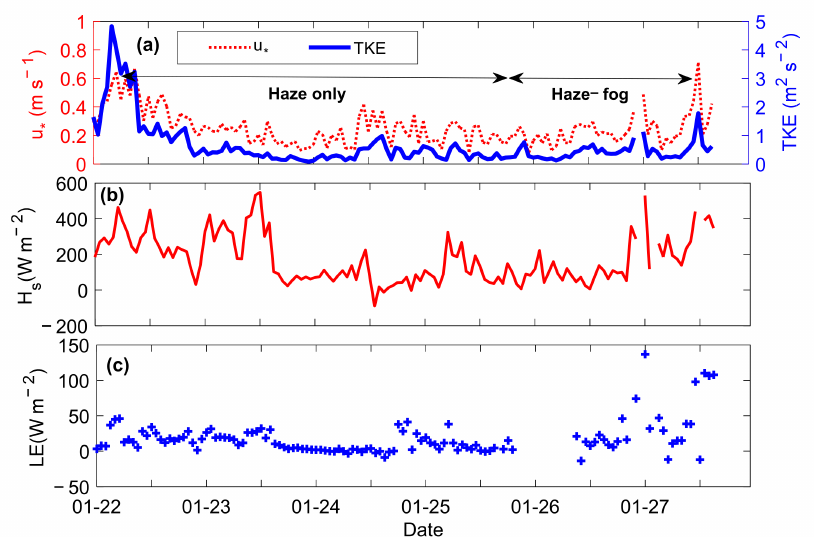
Figure 9. Variation in hourly mean ( a ) friction velocity ( u * ) and turbulent kinetic energy (TKE), ( b ) sensible heat flux (H s ), and ( c ) latent heat flux (LE) observed at the IAE station in Shenyang during 22–27 January 2021.